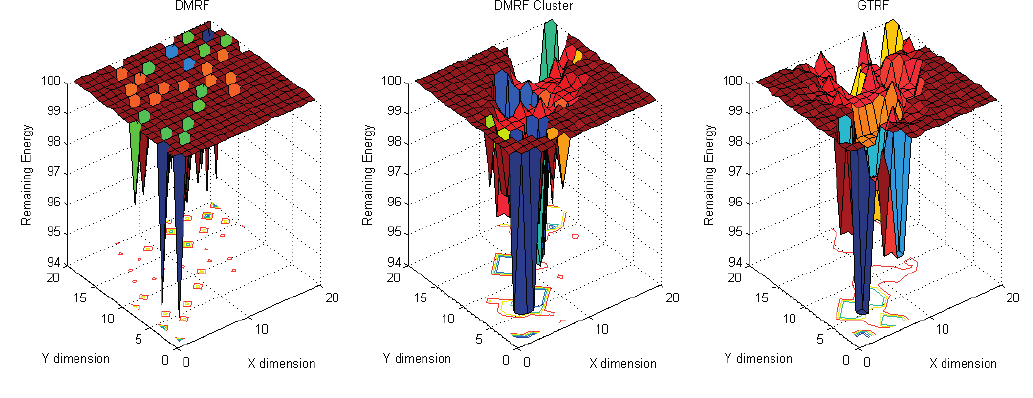
Figure 4. Energy cost with fixed source and fixed sink with selfish nodes.